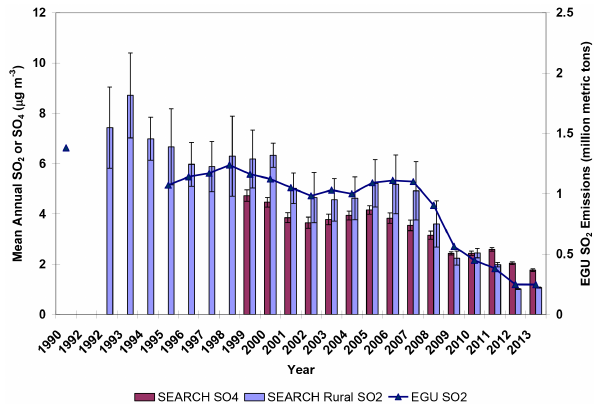
Figure 2. Mean annual SO 4 concentrations (all SEARCH sites) and SO 2 concentrations (rural SEARCH sites – CTR, OAK, YRK) com- pared with emissions of SO 2 from EGUs located in Alabama, Geor- gia, northwest Florida, and Mississippi vs. year. Uncertainties are 1 standard error of the inter-site means. EGU emissions are updated from Blanchard et al.